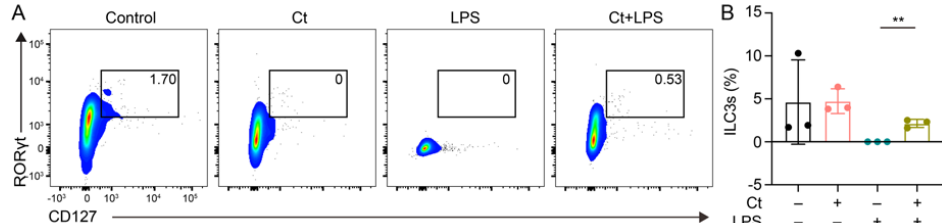
Figure 4. Effects of Ct on proportion of ILC3s in mice. Each dot presented one mouse . Data presented as mean ± SEM. ** p < 0.01 by two-way unpaired t -tests. ** p < 0.01 by two-way unpaired t